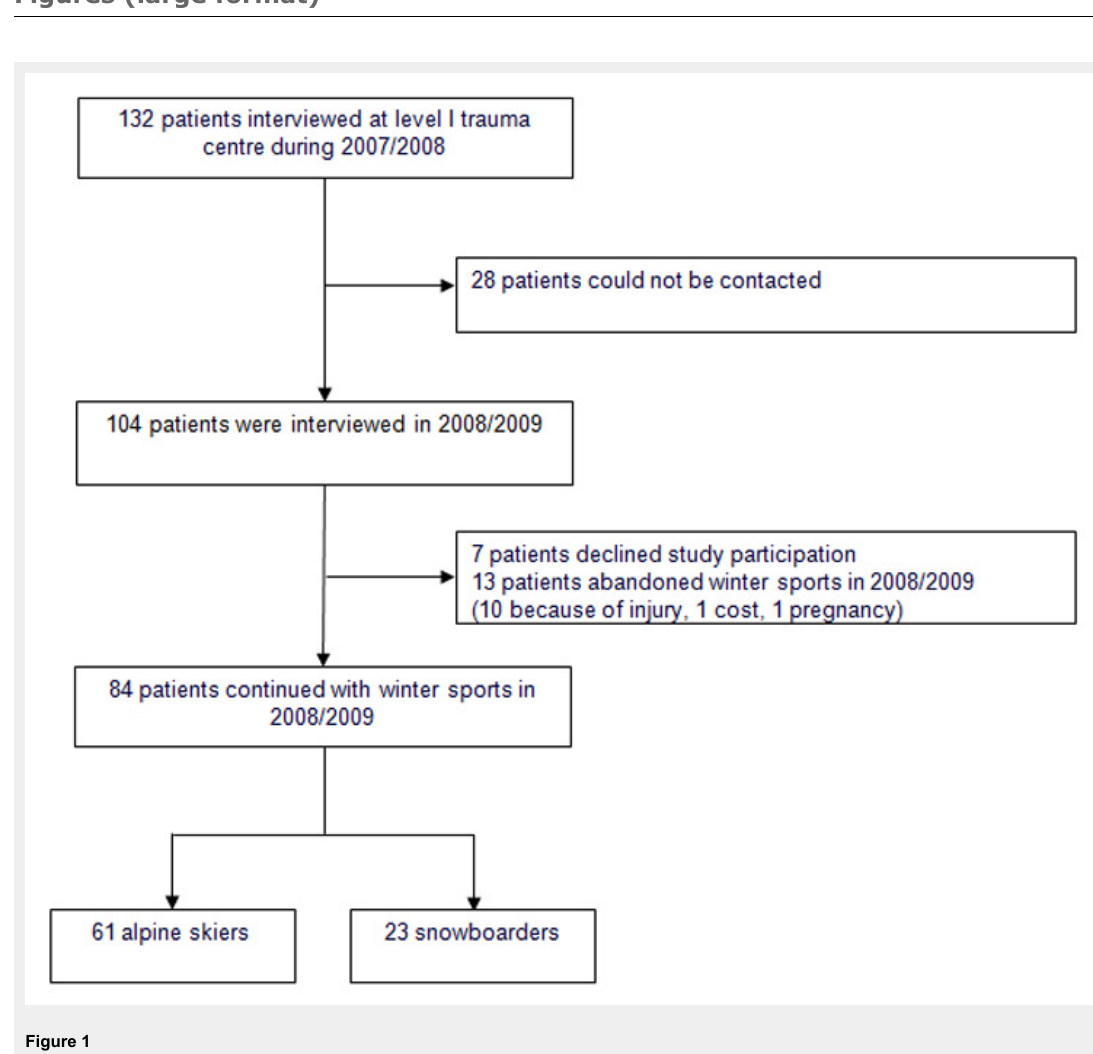
Figure 1 Flow chart of study